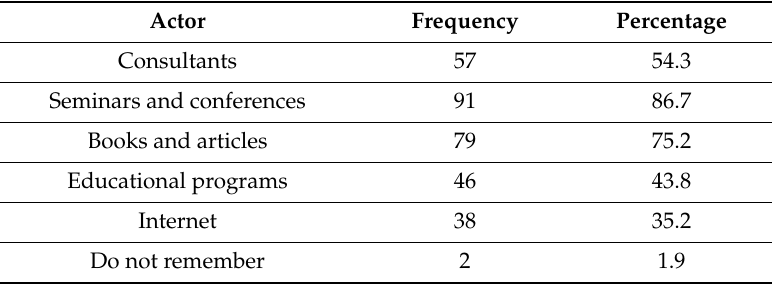
Table 4. Contact points (N = 105).